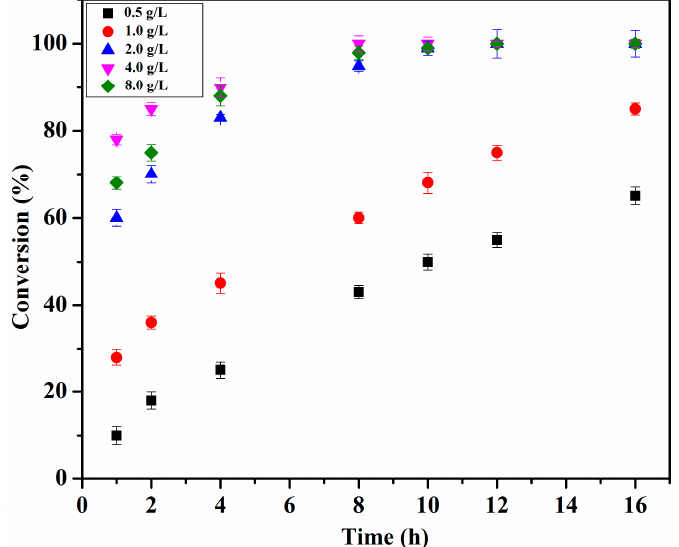
Figure 4. Enzyme loading effect on the conversion of chloramphenicol. Reaction conditions: chloramphenicol 0.25 M in 1,4-dioxane; vinyl propionate/chloramphenicol = 5:1; T = 50 °C; 8 h and 200 rpm.